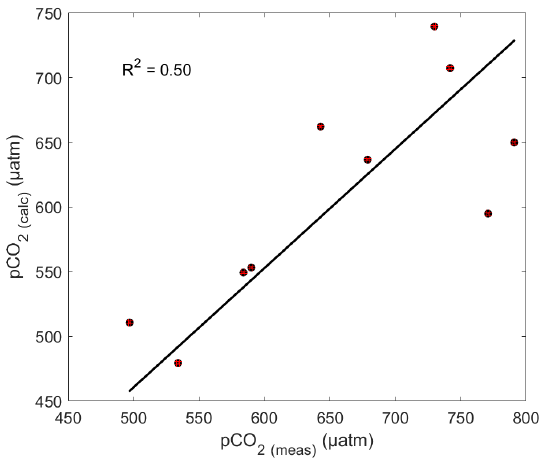
Figure 5. Correlation between p CO 2(SW-meas) and p CO 2(SW-calc) for May 2018. The black line shows the linear regression with a null intercept ( R 2 = 0 . 50). Error bars, in red, are smaller than the